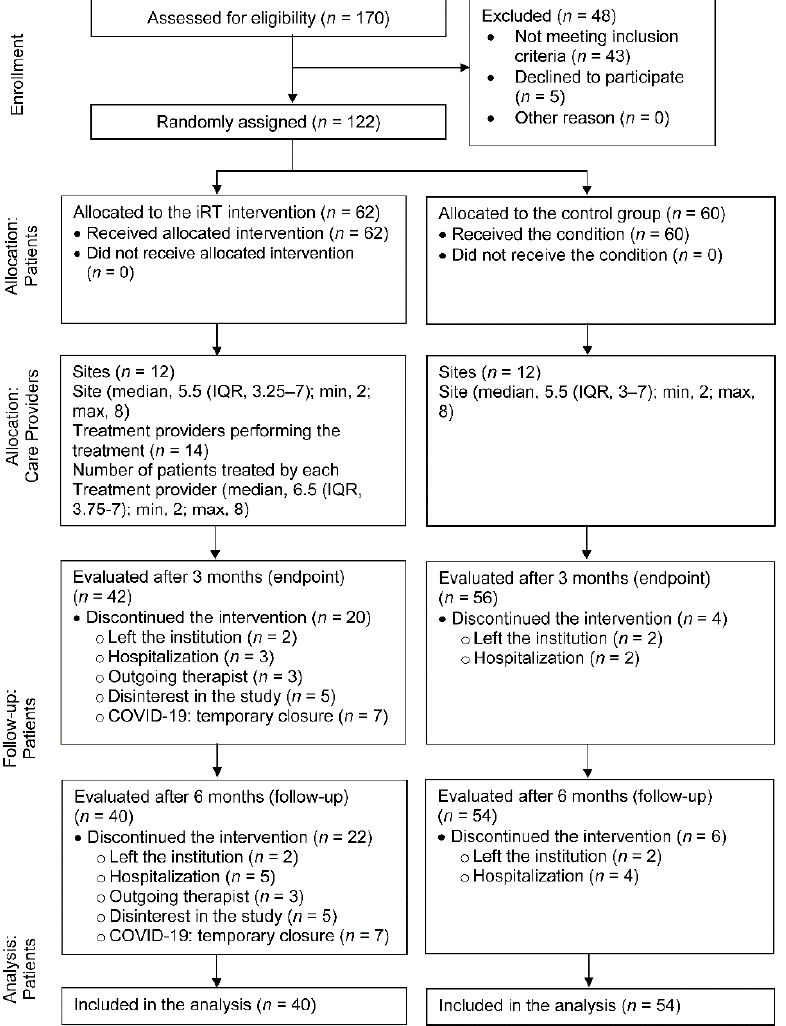
Figure 1. CONSORT diagram of participant flow through the study. Abbreviations: IQR = interquartile range; iRT = individual reminiscence therapy.